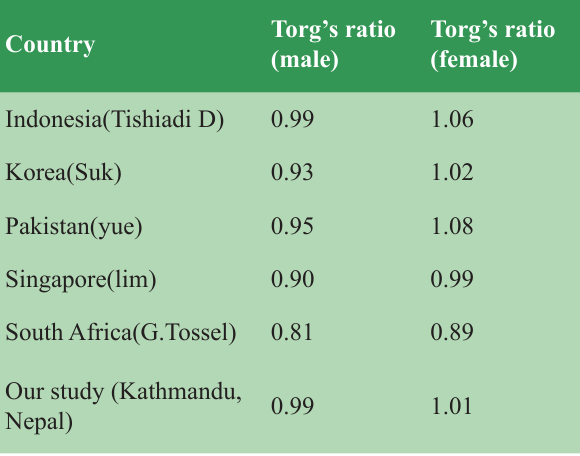
Table 4: Comparison of Torg’s ratio to other population